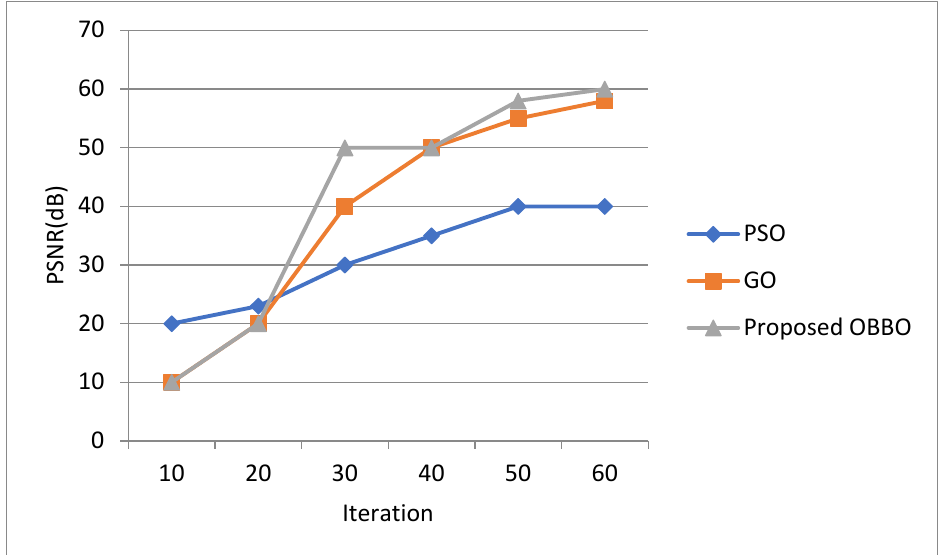
Figure 6. Fitness comparison with existing algorithms.